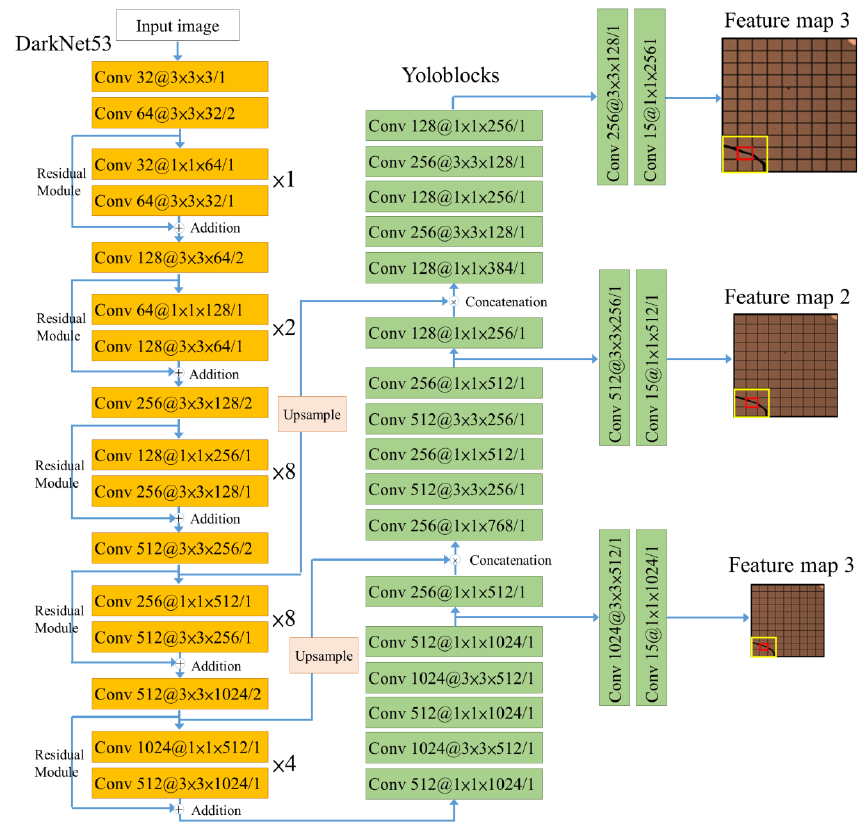
Figure A2. Architecture of the YOLOv3 network.